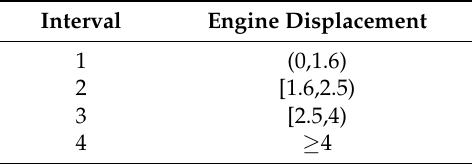
Table 5. The intervals of engine